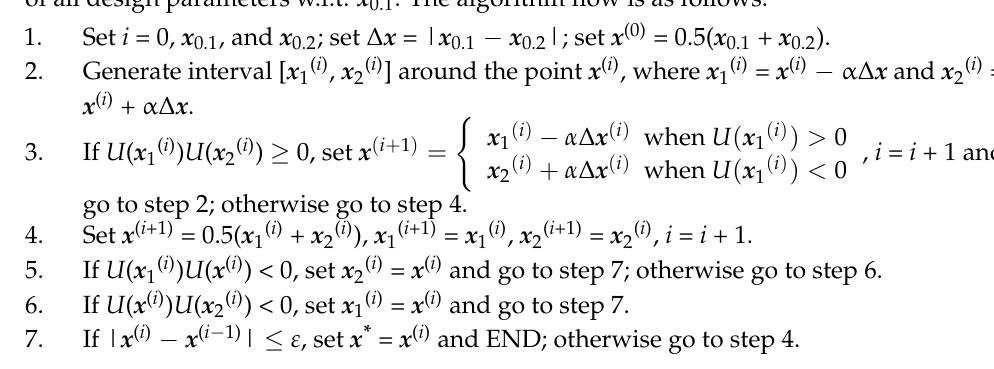
Figure 3. Frequency characteristics of the composite (solid gray) and assembled (dashed black) BM models at some design: ( a ) reflection and isolation, ( b ) transmission, and ( c ) phase difference between output ports. The responses are obtained for excitation of both structures through the first input port.